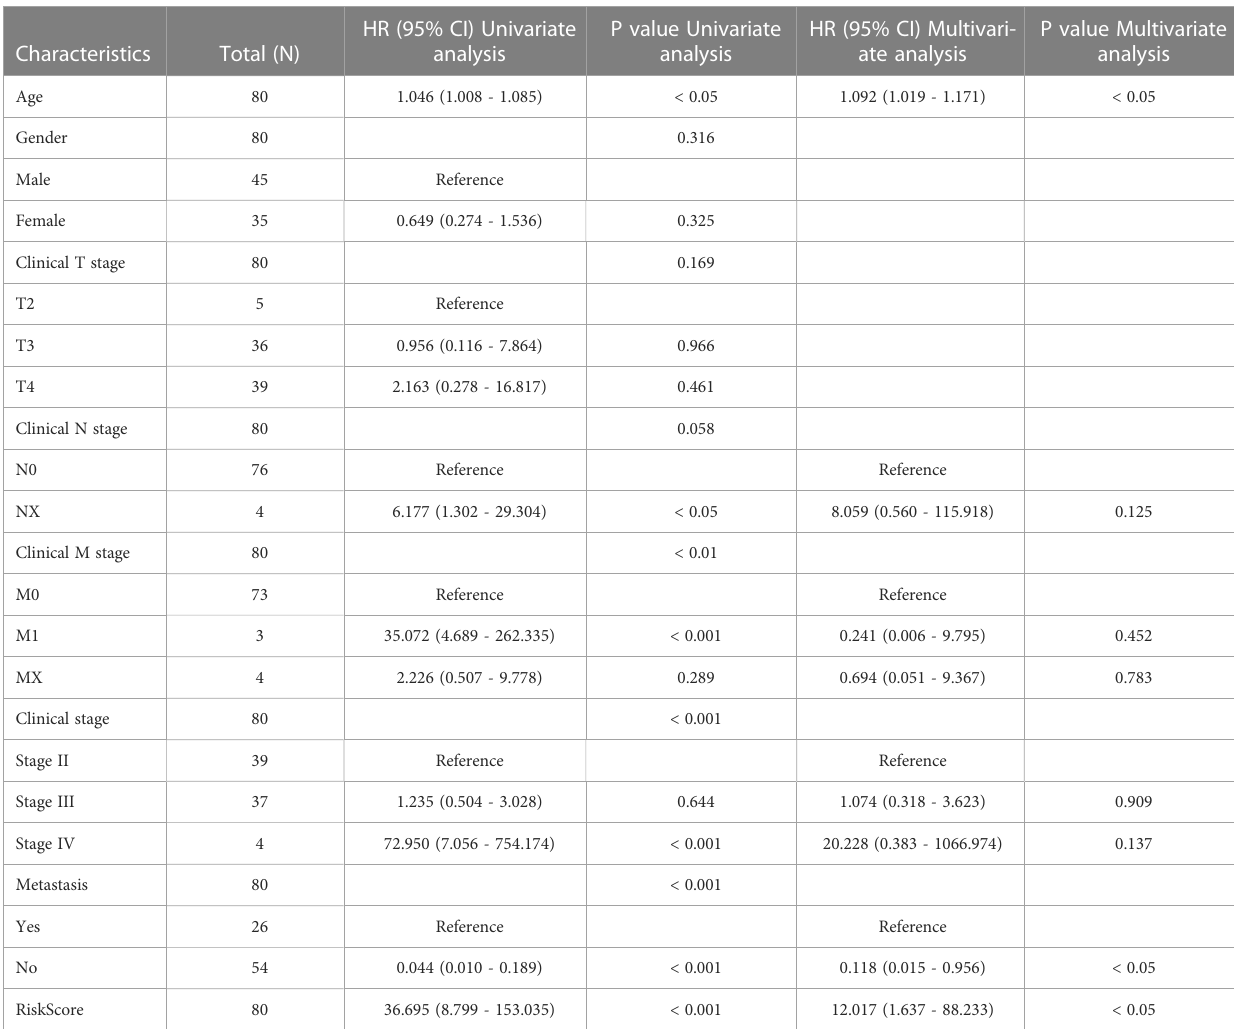
TABLE 1 Univariate analysis of risk score and characteristics in training